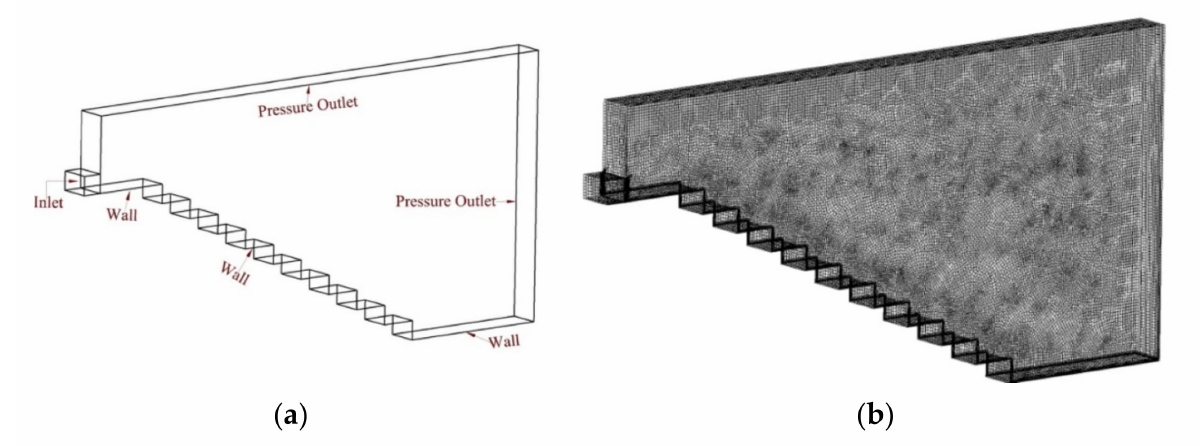
Figure 3. ( a ) Boundary conditions of the whole domain; ( b ) overall view of the